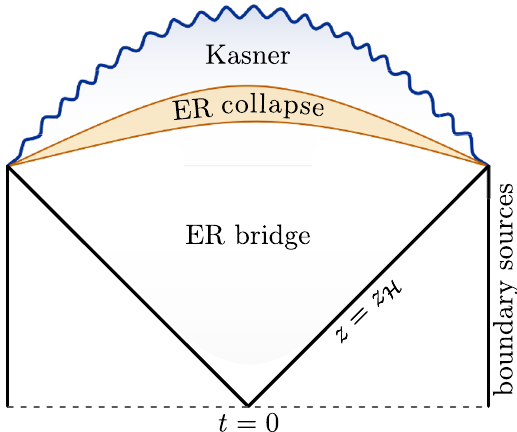
Figure 1 . Schematic illustration of the interior of a charged AdS black hole in Einstein-Maxwell theory with a small scalar (cid:12)eld source. It begins close to RN-AdS with its standard Einstein-Rosen (ER) bridge. This undergoes a rapid collapse discussed in section 4, followed by a Kasner cosmology towards the singularity, discussed in section 5. The Penrose diagram is considered in more detail section 6. The black solid lines indicate the boundary and horizon of the